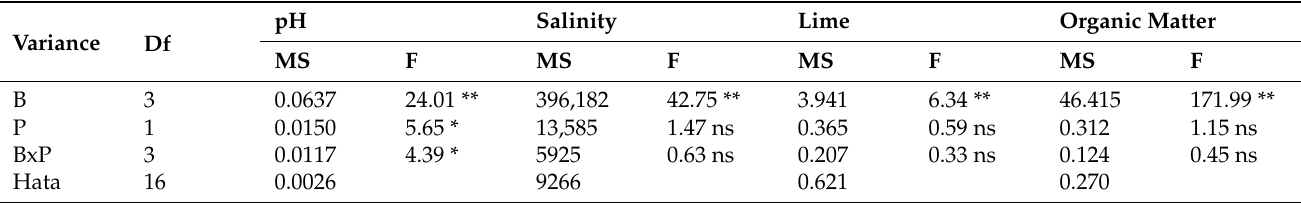
Table 2. Variance analysis table for the effects of biochar and PGPR applications on some properties of the trial soil.